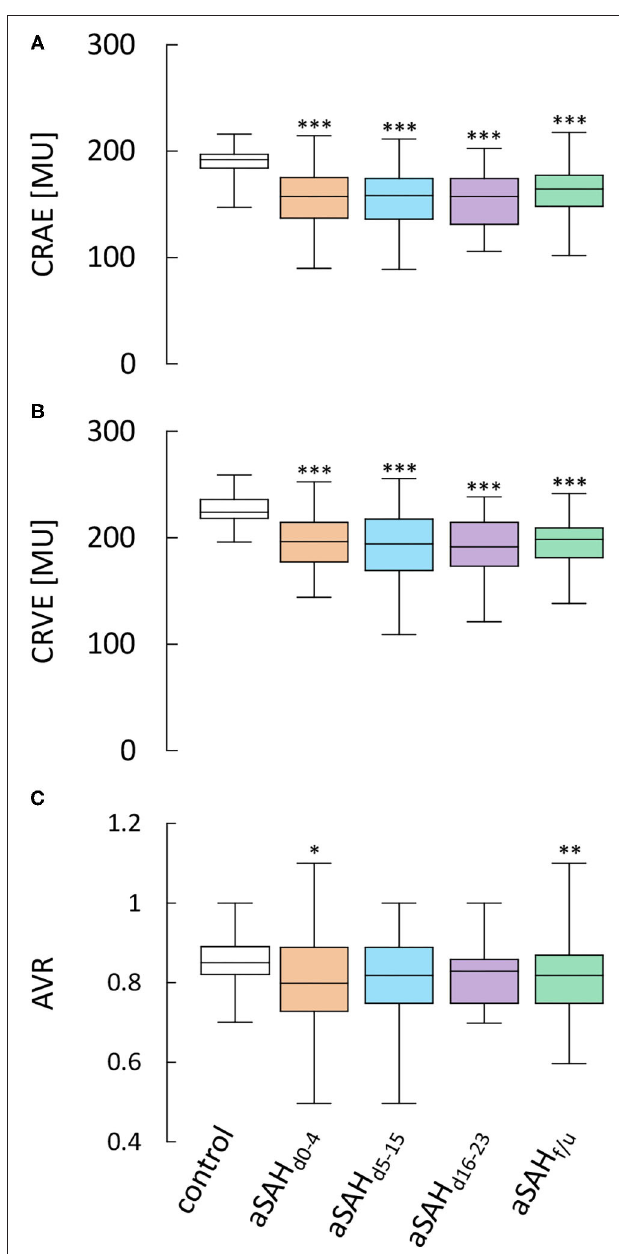
FIGURE 2 | Results from static RVA in aSAH patients and control subjects. Comparison of (A) central retinal arterial equivalent (CRAE) as a measure of arterial diameter, (B) central retinal venous equivalent (CRVE) as a measure of venous diameter and (C) retinal arterio-venous-ratio (AVR) in control subjects and aSAH patients during the early (aSAH d0 − 4 ), critical (aSAH d5 − 15 ) and late (aSAH d16 − 23 ) phase and at follow-up more than 6 weeks after the ictus (aSAH f / u ). *** p < 0.001 vs. control; ** p < 0.01 vs. control; * p < 0.05 vs. control.